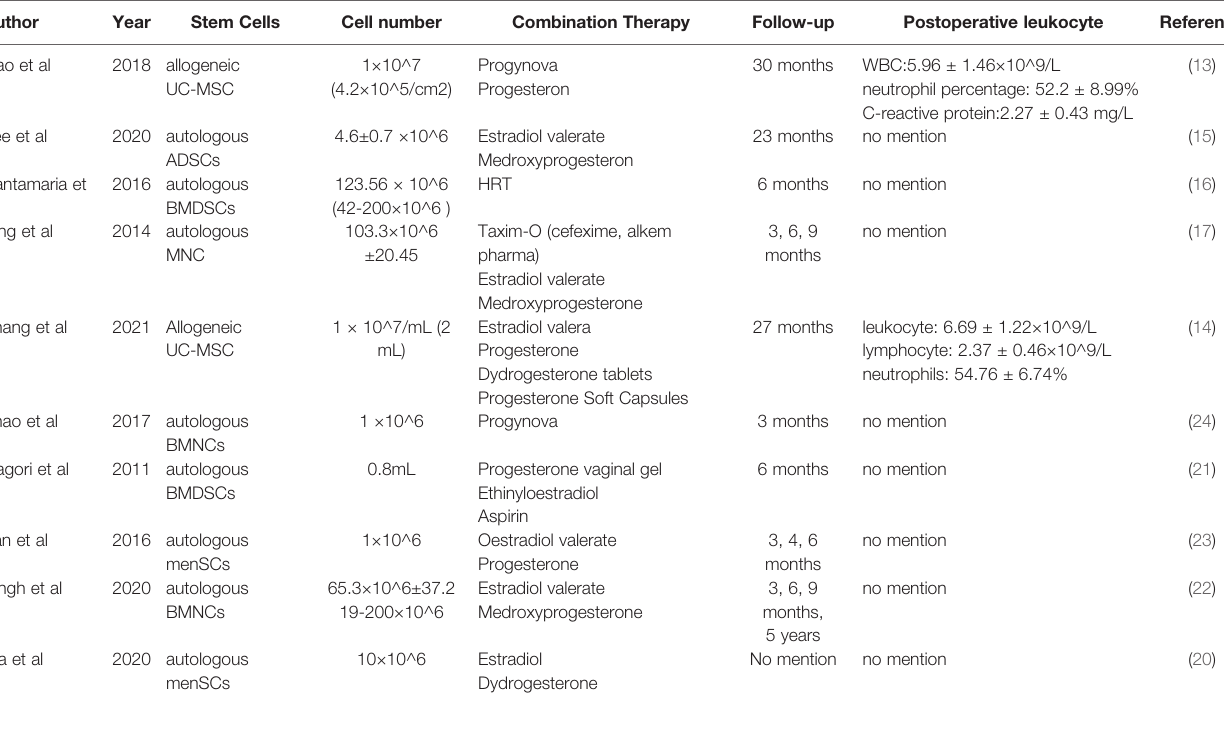
TABLE 2 | Characteristics of